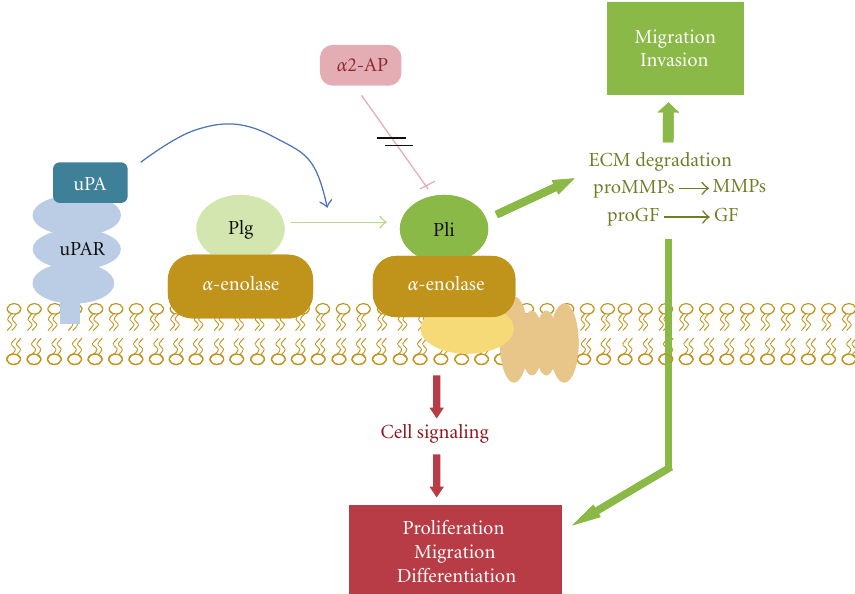
Figure 3: Schematic overview represents α -enolase/plasminogen interaction on the cell surface. α -Enolase enhances plasminogen activation on the cell surface, concentrates plasmin proteolytic activity on the pericellular area and protects plasmin from its inhibitor α 2-antiplasmin. Once activated, plasmin can degrade most of the components of the extracellular matrix, directly or indirectly by activating metalloproteases. It is also capable to activate prohormones of progrowing factors. Abbreviations: Plg, plasminogen; Pli, plasmin, α 2-AP, α 2-antiplasmin; uPA, urokinase-type plasminogen activator, uPAR, urokinase-type plasminogen activator; ECM, extracellular matrix; MMPs, metalloproteases; GF, growing